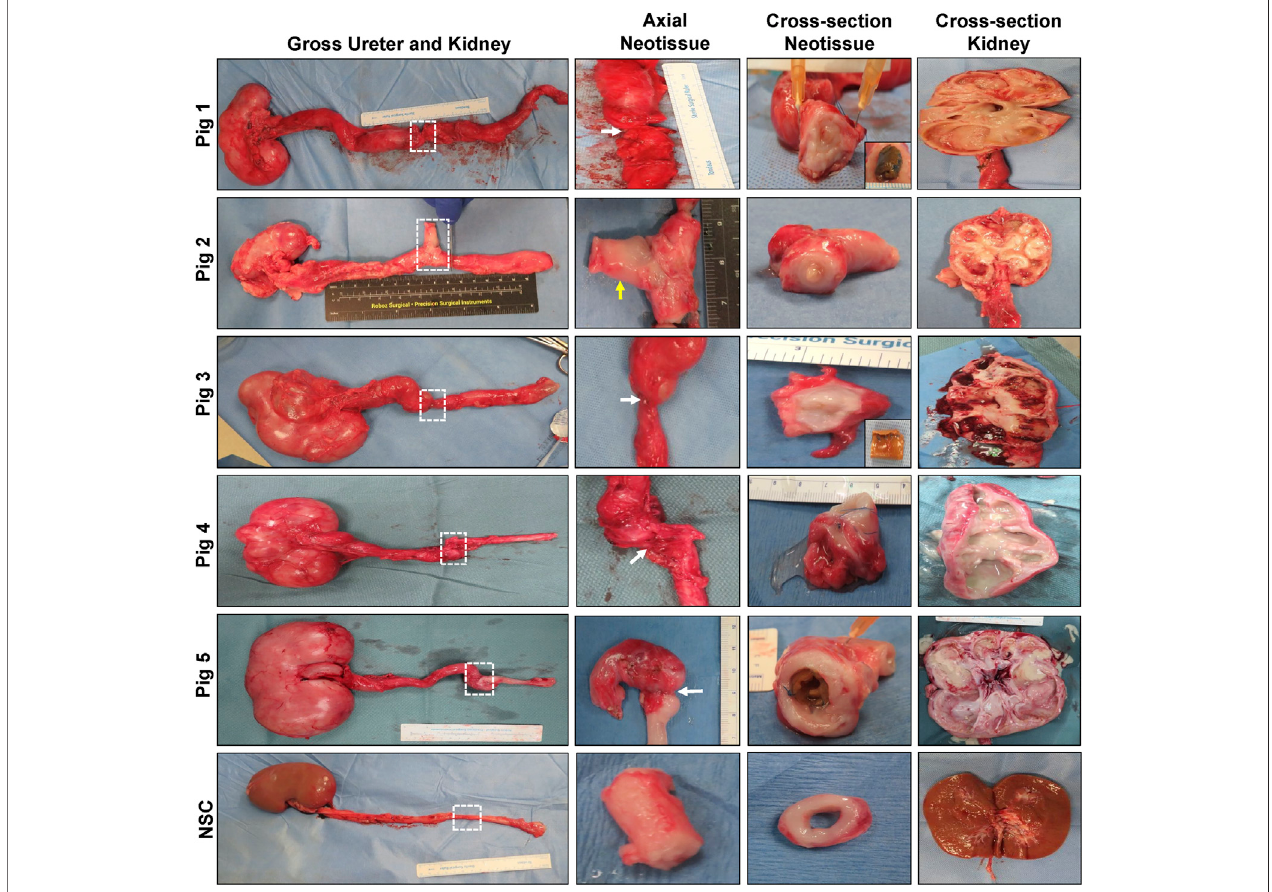
FIGURE 3 | Necropsy evaluations of ureteral neotissues and reconstructed collecting systems. First column: Photomicrographs of gross collecting systems and reconstructed areas (boxed) in Pigs 1 – 5 after 12 weeks of scaffold implantation as well as parallel nonsurgical controls (NSC). Second and third columns display axial and cross-sectional views ofneoconduits from originalgraftsites, respectively.White arrows denote central stricture formation inneotissues and the yellow arrow marks fi stula formation. Insets display bulk scaffold remnants isolated from the distal ureter. Cross-sectional view of kidneys from operated collecting systems or NSC are shown in the fourth